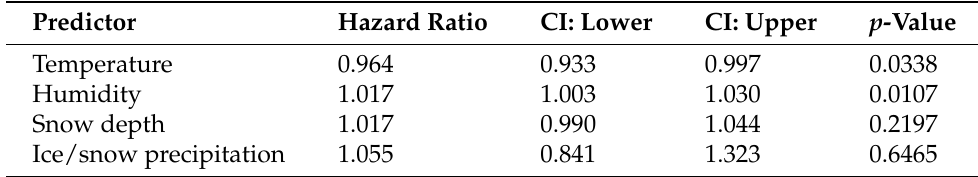
Table 4. Estimates from the fitted stratified Cox model.